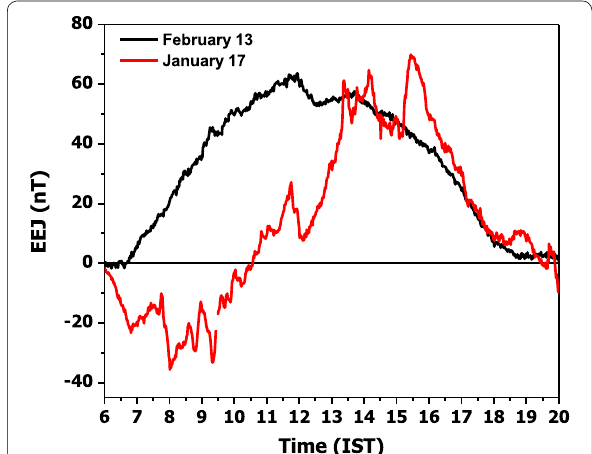
Fig. 4 The time variation of EEJ on January 17, 2005 as compared with the control